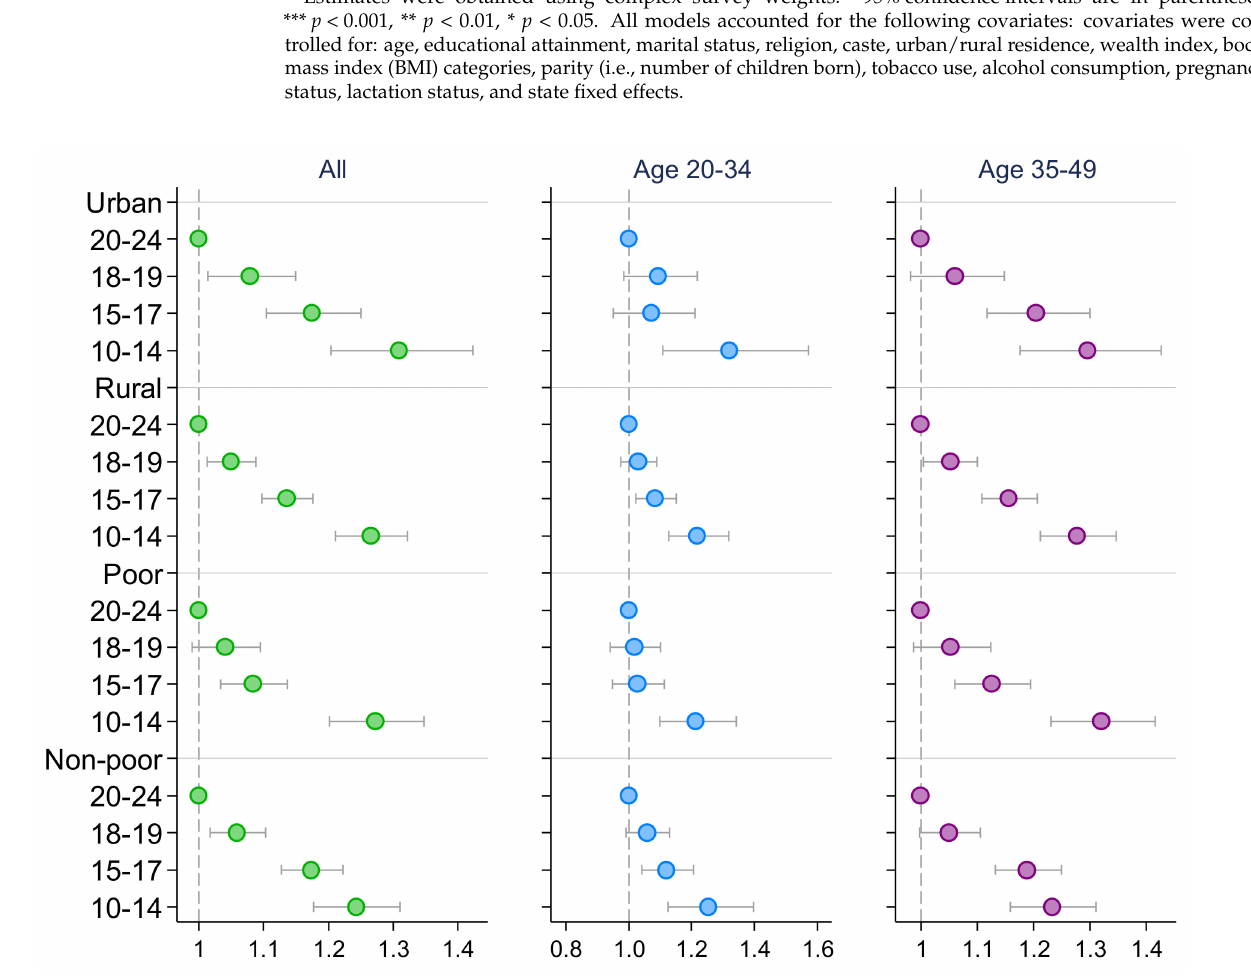
Figure 5. Adjusted odds ratios in favor of having high blood pressure for age at marriage in urban/rural and poor/non-poor sub-samples. Estimates were obtained using complex survey weights. The horizontal lines across the markers represent 95% confidence intervals. All regressions included the following covariates: age, educational attainment, marital status, religion, caste, wealth index quintiles (for urban/rural sub-samples only), urban/rural residence (for poor/non-poor sub- samples only), body mass index (BMI) categories, parity (i.e., number of children born), tobacco use, alcohol consumption, pregnancy status, lactation status, and state fixed